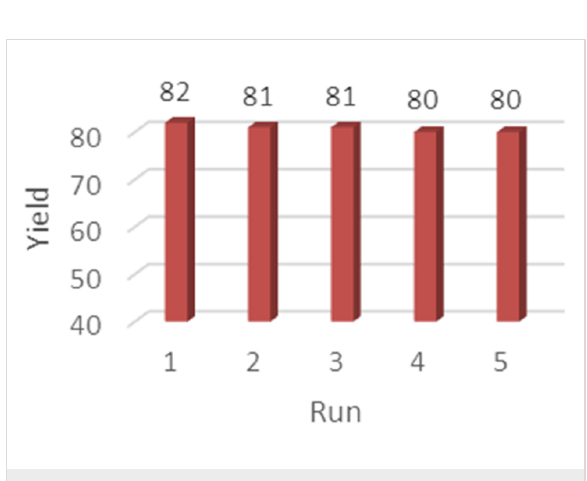
Figure 1: Investigation of the reusability of Al 2 O 3